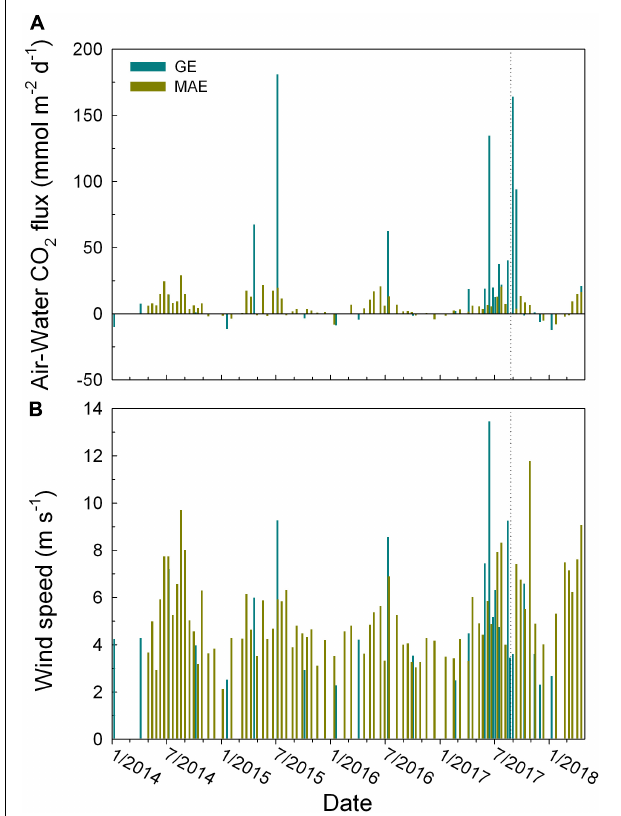
FIGURE 5 | Temporal distributions of (A) air–water CO 2 flux (unit mmol m − 2 d − 1 ) and (B) daily wind speed on the sampling days in GE (dark green) and MAE (dark yellow). The dotted lines represent the date (August 25, 2017) on which Hurricane Harvey made landfall.